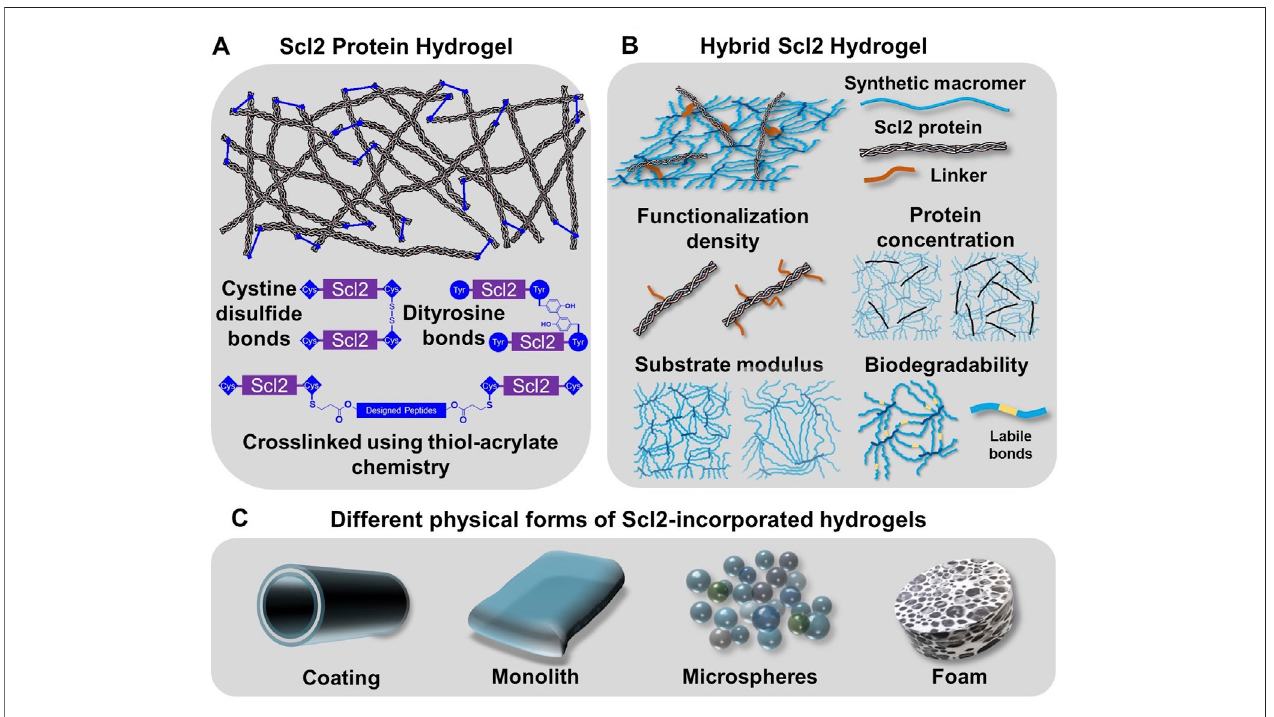
FIGURE3| IncorporationofScl2proteinsintohydrogelsasalternativematerialstoanimal-derivedcollagenmatrices. (A) Scl2proteinhydrogelnetworkwithvaried crosslinkingmodalitiesfor enhanced gel stability. (B) Hybrid Scl2 hydrogels withthe Scl2 protein anchored intoasynthetichydrogel networkviaafunctionalization linker and the different parameters used to modulate hydrogel properties. (C) Different physcial forms of hybrid Scl2 hydrogels used in biomedical applications.